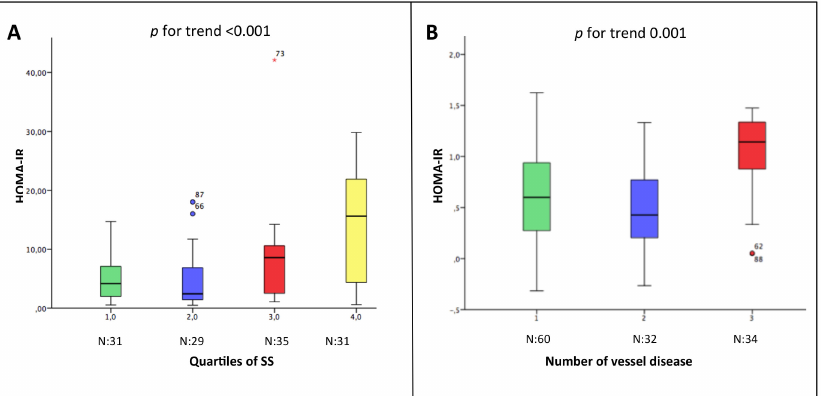
Figure 2. Relation between the HOMA-IR and the severity (Panel A ) and the extension (Panel B ) of coronary atherosclerosis. In Panel A , patients are divided per tertiles of Syntax Score. In Panel B , patients are divided based on the number of vessel disease. * Outliers.